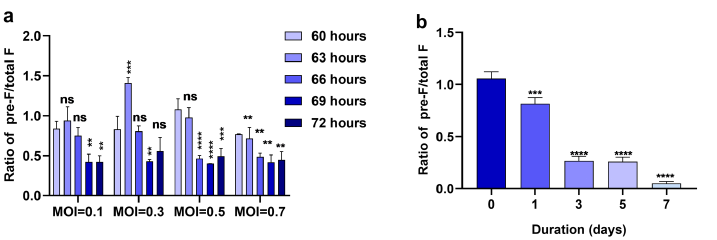
Figure 1. Production of high-pre-F RSV virus stocks and thermal stability assay results. ( a ) Vero cells were infected with RSV A2 at the indicated MOI, and the virus was harvested at the indicated time points. The ratio of the results of sandwich ELISA using AM22, a pre-F-specific antibody, to the results of sandwich ELISA using motavizumab, a total F antibody, is shown. ( b ) The thermal stability of pre-F was tested by incubation with virus at 4 °C, and the ratio of pre-F to total F was calculated by sandwich ELISA at the indicated time points. All bars represent the mean ± SD from three experimental replicates combined and ( a ) the data were analyzed by two-way ANOVA followed by Dunn’s multiple comparisons post hoc test to compare the ratio of 60 h post infection with the ratio of each other time of infection ( b ) the data were analyzed by one-way ANOVA followed by Dunn’s multiple comparisons post hoc test to compare the ratio on day 0 with the ratio on each other day. The p values are shown by asterisks (ns, not significant; ** p < 0.01; *** p < 0.0001; **** p <